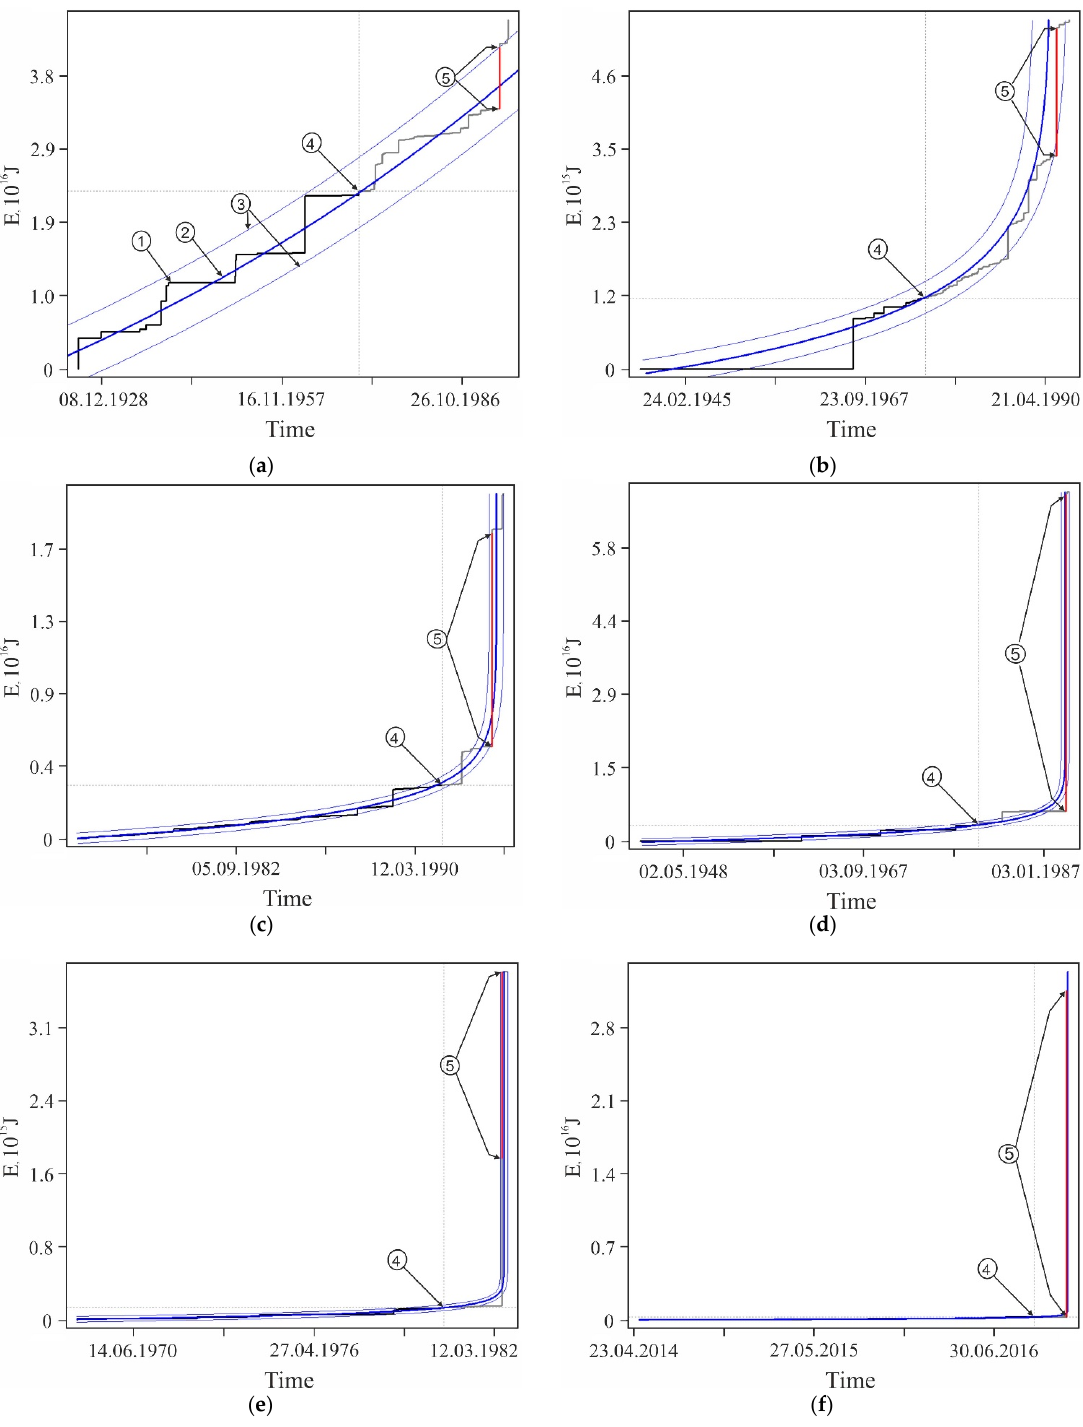
Figure A2. Examples of some foreshock extrapolations of the energy flux. Figures in circles: 1— factual data curve, 2—calculated curve, 3—errors band (±3 σ ), 4—retrospective prediction moment and 5—strong earthquake. The graphs correspond to the data in Table A1. The intersection of the vertical and horizontal dotted lines on the graphs corresponds to the ‘current’ values of time and parameter, there is the ‘past’ to the left and below this intersection and the ‘future’ to the right and above.